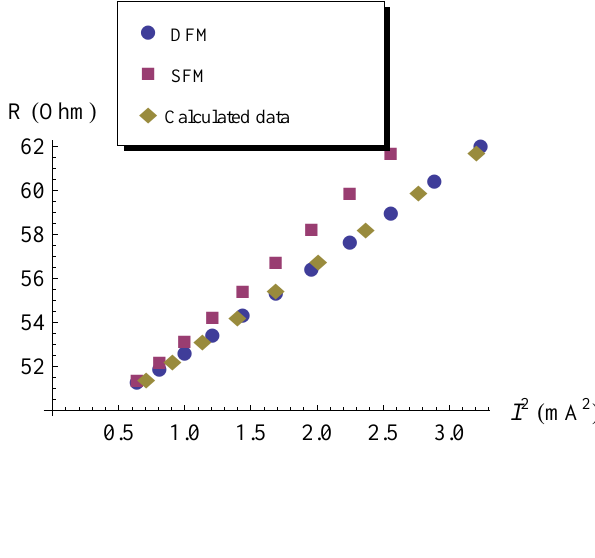
Resistances of the emitter of the DFM and the SFM corresponding to the heating